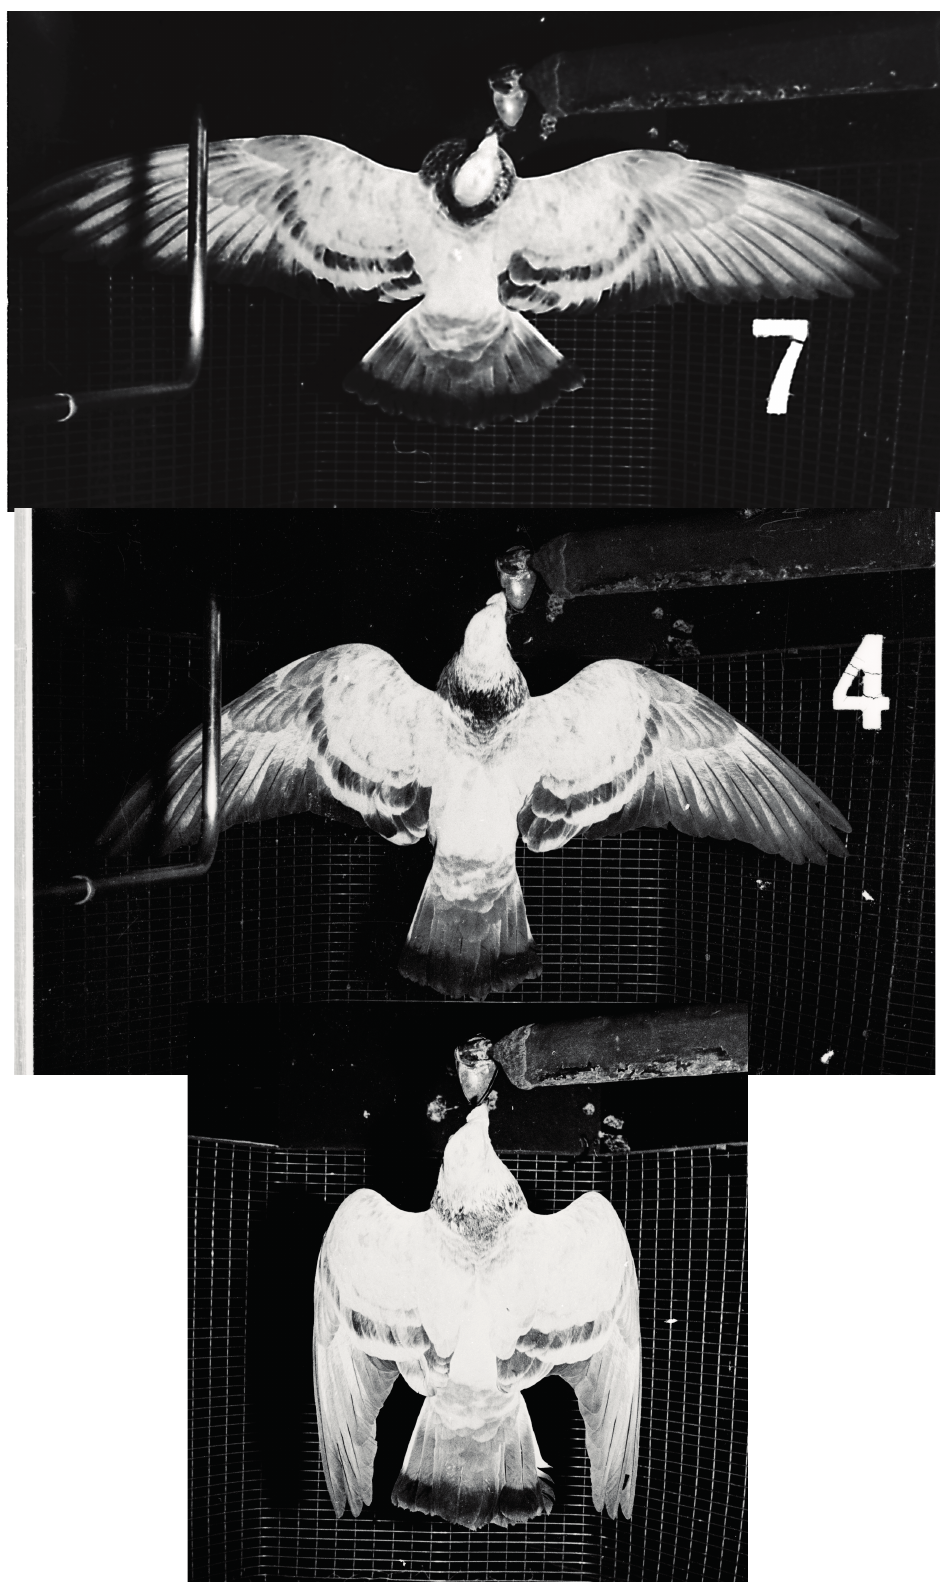
Figure 3. A pigeon gliding in the Bristol wind tunnel, showing planform variations with speed. There are no mechanical constraints with this in a bird wing, but there are in bat or pterosaur wings. The lift coefficient went from 1.3 to 0.3, not taking account of the tail area. It would have been much lower at high speeds, if the full span had been